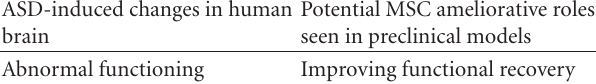
Table 1: Potential ameliorative e ff ects mediated by MSCs in ASD